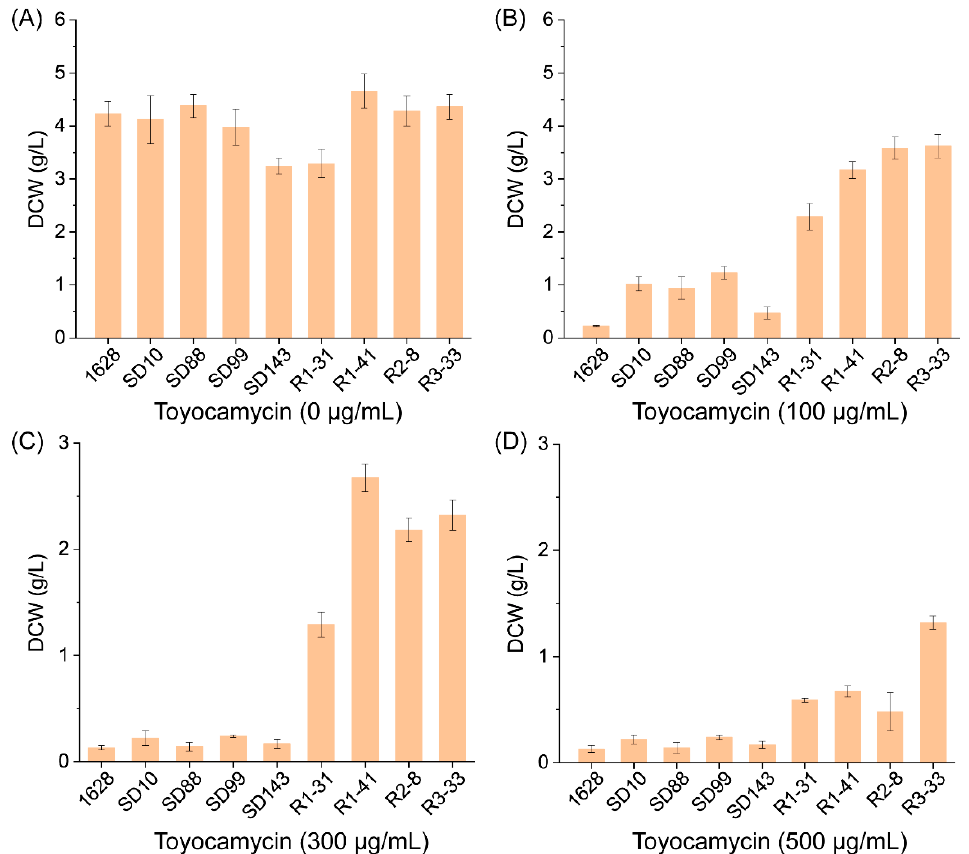
Figure 2. The product resistance of the mutants and parent strains. The DCWs were monitored after inoculating for 96 h at 28 °C in the GYM medium with increasing concentrations of toyocamycin ( A ) 0 μ g/mL; ( B ) 100 μ g/mL; ( C ) 300 μ g/mL; ( D ) 500 μ g/mL.